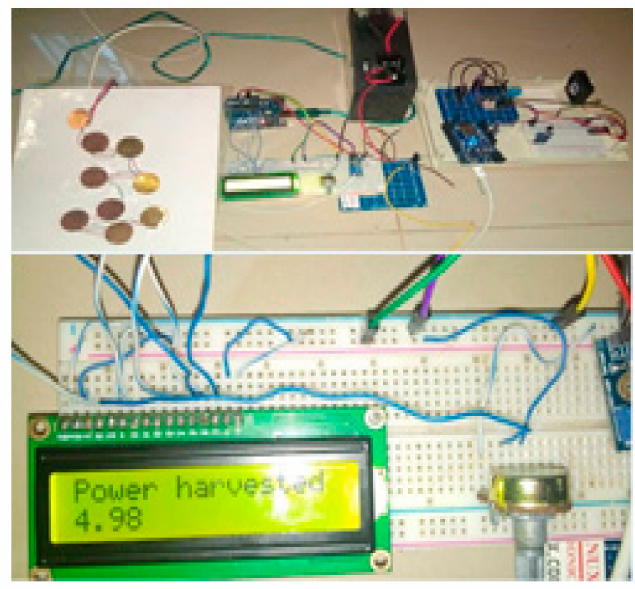
Figure 8. Piezoelectric energy harvesting prototype